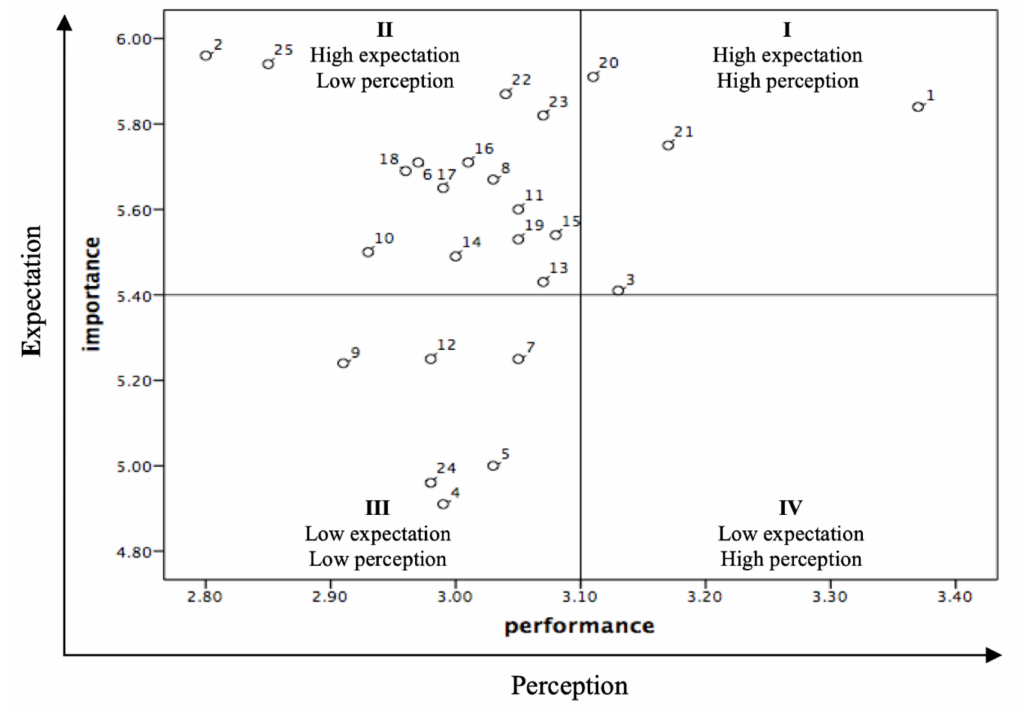
Figure 2. The expectation–perception matrix of